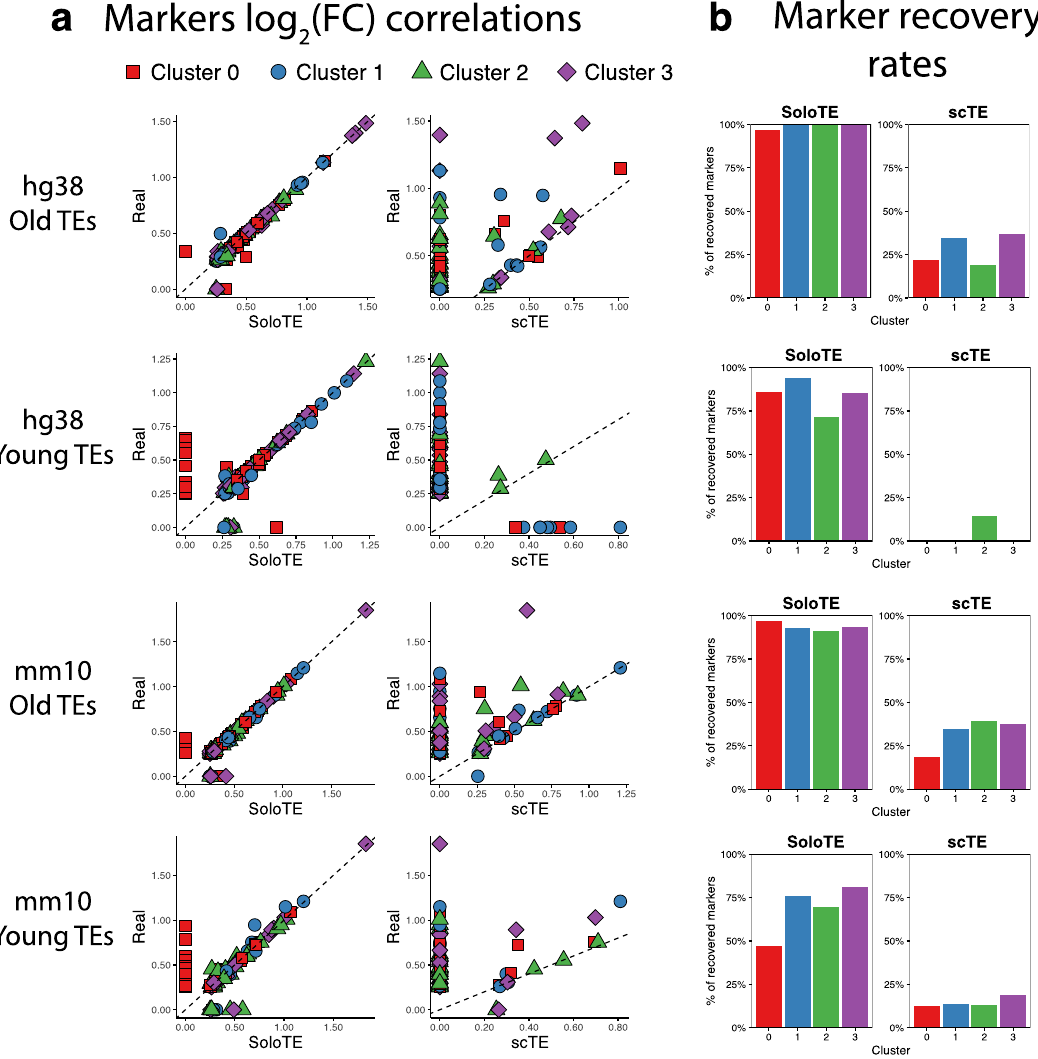
Fig. 3 Comparison of predicted cell markers between SoloTE and scTE. a For each simulated dataset, correlation plots of the average log 2 (FC) are depicted, with the real value on the y axis, and the method (SoloTE or scTE) on the x axis. Cluster 0 markers are shown in red squares, Cluster 1 markers in blue circles, Cluster 2 markers in green triangles and Cluster 3 markers in purple diamonds. Dashed line at y = x was added to aid in visualization of under- and over-estimation of values. b Bar plots showing the rate of markers retrieved by each method. Cluster identi fi er is indicated on the x axis, whereas the percentage of correctly recovered markers on the y